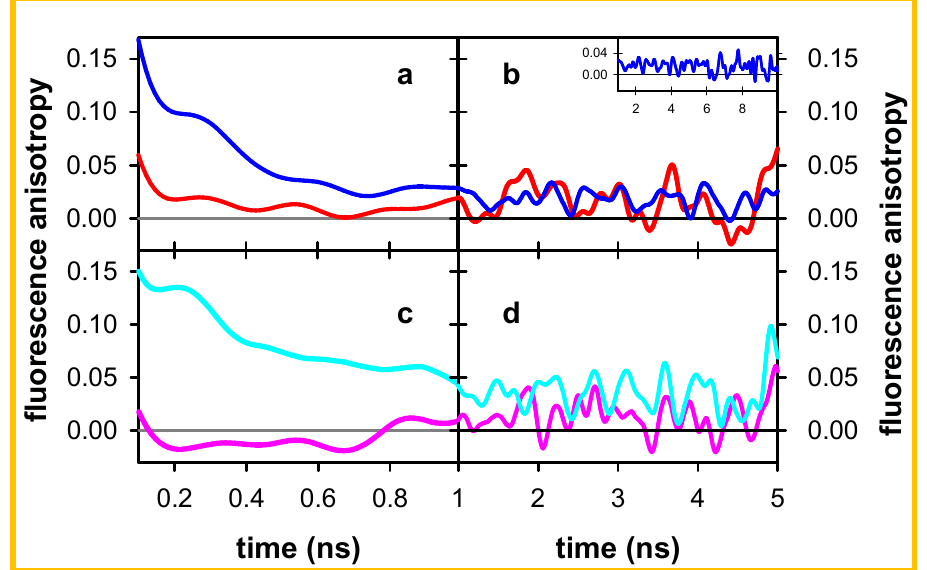
Figure 8. Fluorescence anisotropy traces determined for pA • pT ( a , b ) and A 20 • T 20 ( c , d ) in standard buffer at 305 nm (blue, cyan) and 420 nm (red, pink) on the sub-ns ( a , c ) and ns timescales ( b , d ); excitation wavelength: 285 nm. Note that the time axis starts at 0.1 ns.